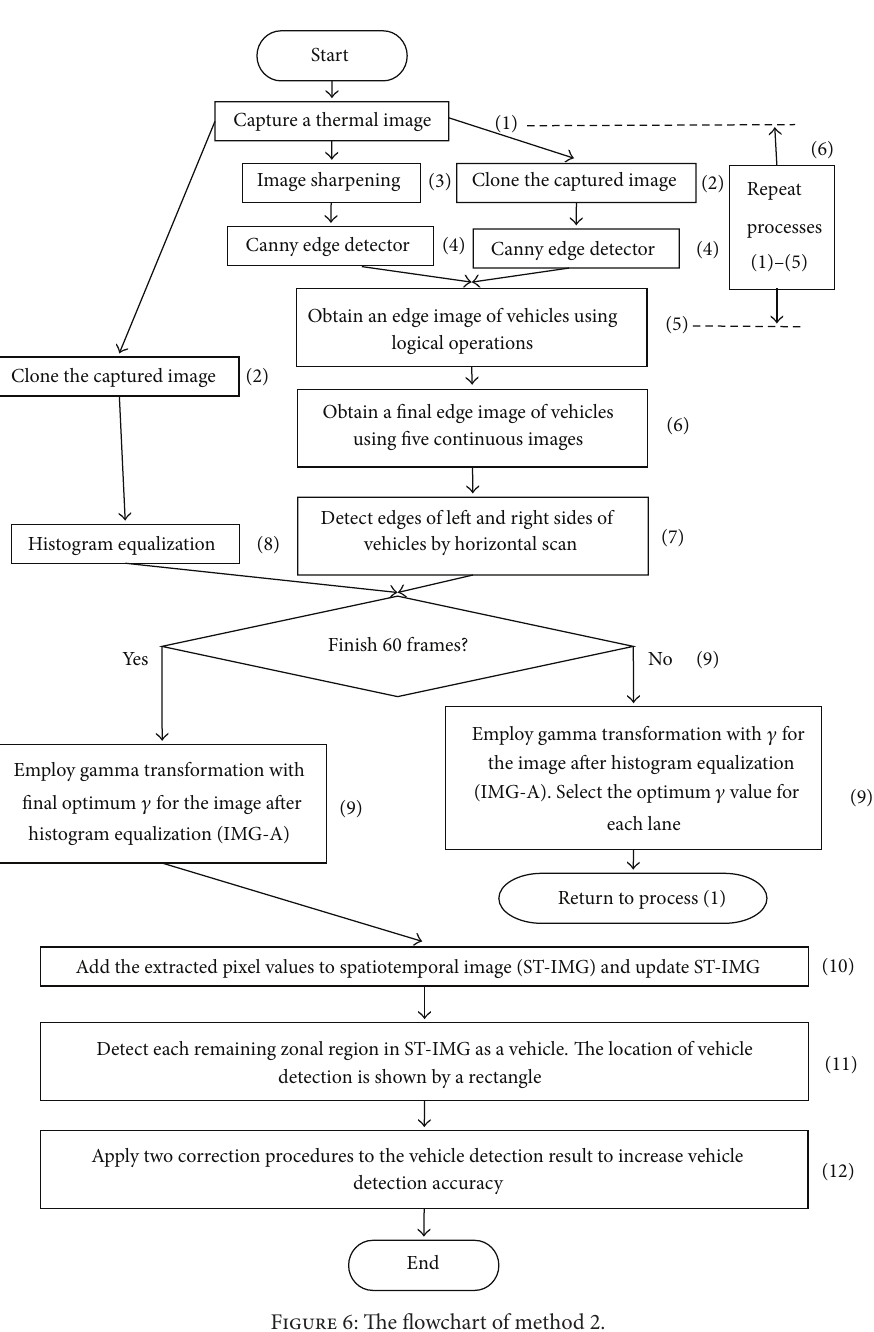
Figure 6: The flowchart of method